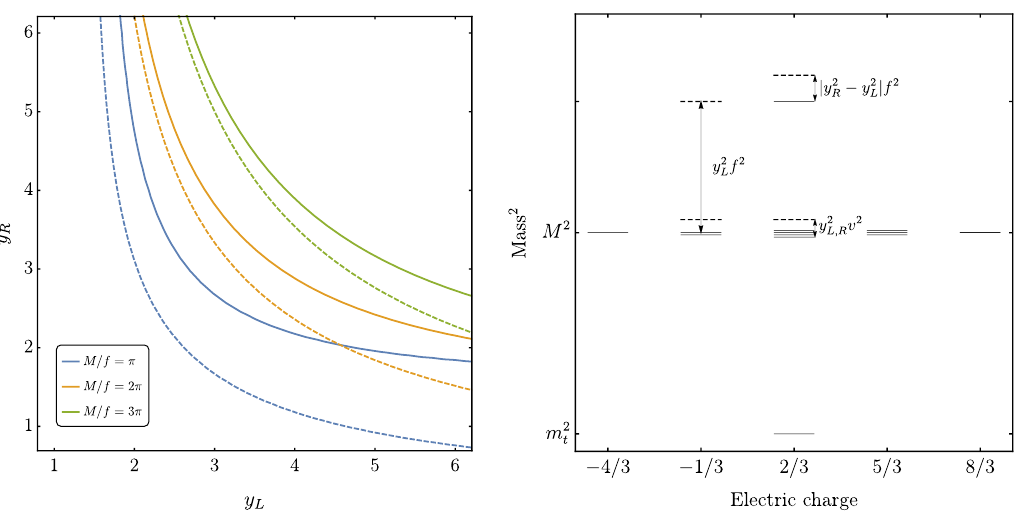
Figure 1 . Left: the m t = 173 GeV contours in the y R − y L plane for M/f = π (blue), 2 π (yellow) and 3 π (green). The solid (dashed) contours refer to the models of Type I (II), as given in eq. (3.2). Right: a representative figure depicting the generic spectrum of the vector-like quarks in models with PC. For Q = 2 / 3 and − 1 / 3 the pair of dashed lines imply that either one of the lines is present in a particular